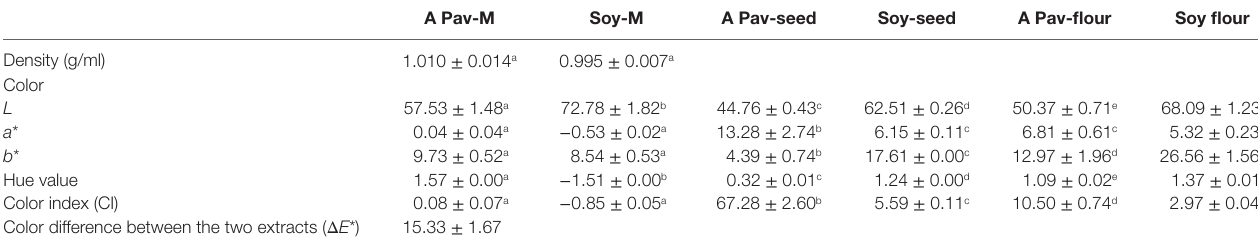
TaBle 1 | Physicochemical qualities of milk extract from Adenanthera pavonina and soy